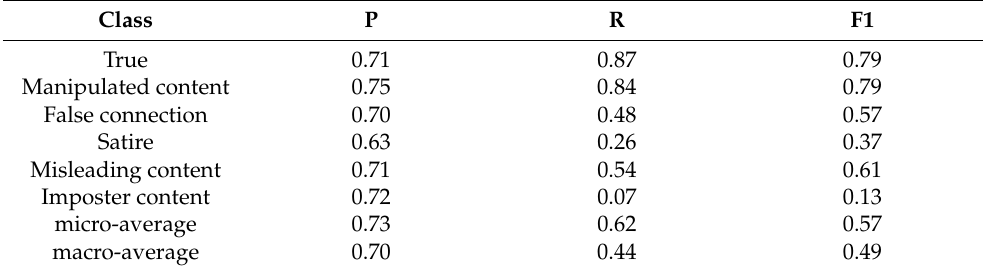
Table 3. Results of CNN with random